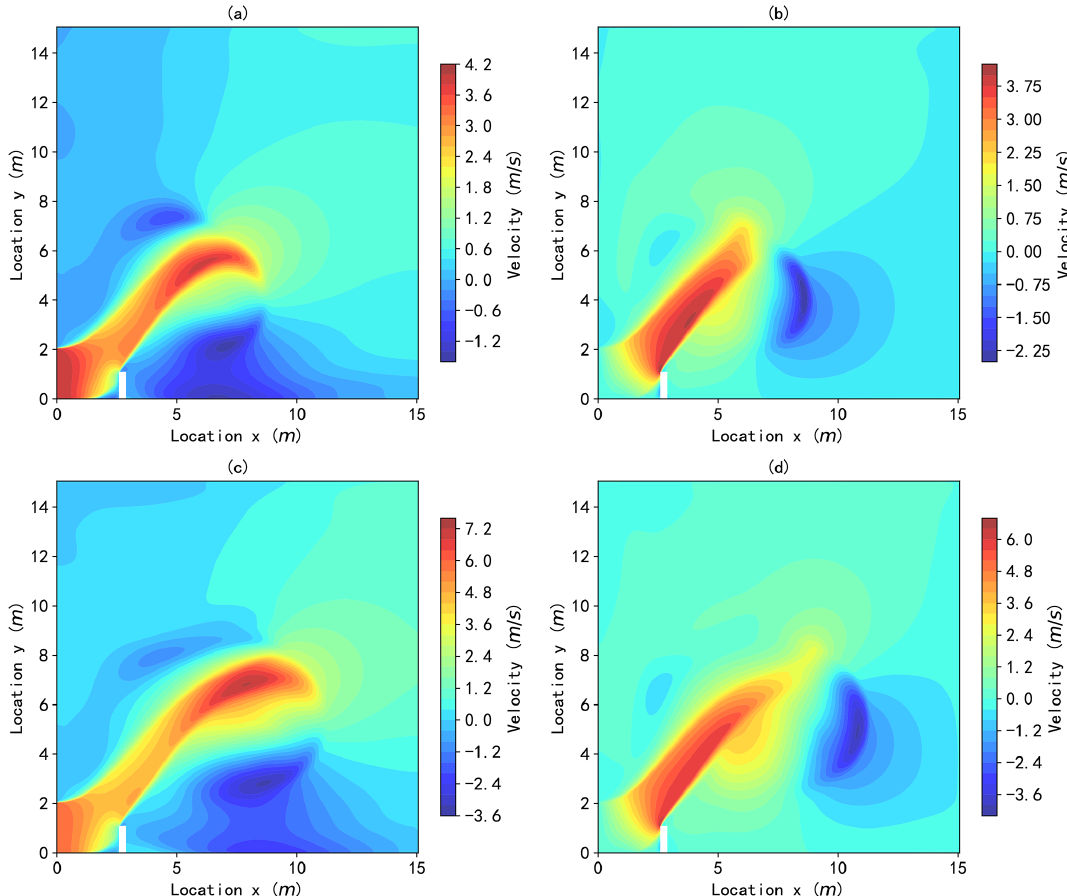
Figure 8. Simulated wind velocity. Panels (a) and (b) represent horizontal and vertical velocities, respectively, for wind 3. Panels (c) and (d) represent horizontal and vertical velocities, respectively, for wind 5. Location x means horizonal position, while Location y means vertical position in a 2D plane